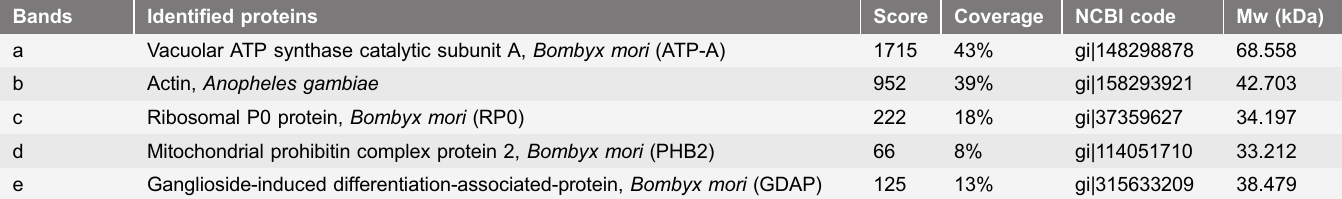
Table 1. Identification of B. mori proteins separated by